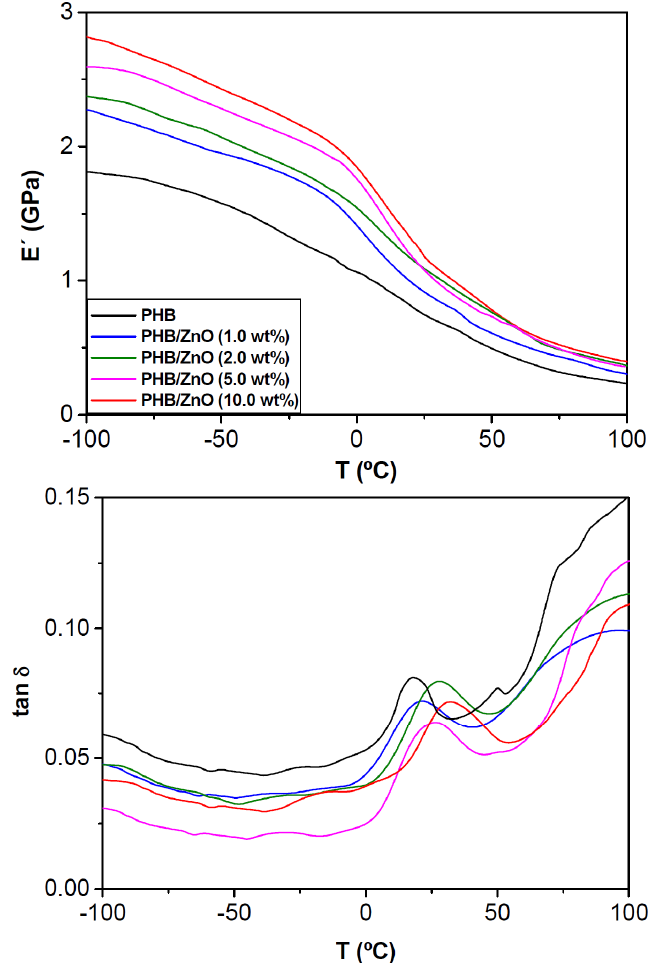
Figure 6. Storage modulus E ' ( top ) and tan δ ( bottom ) as a function of temperature for neat PHB and the nanocomposites with different content of ZnO